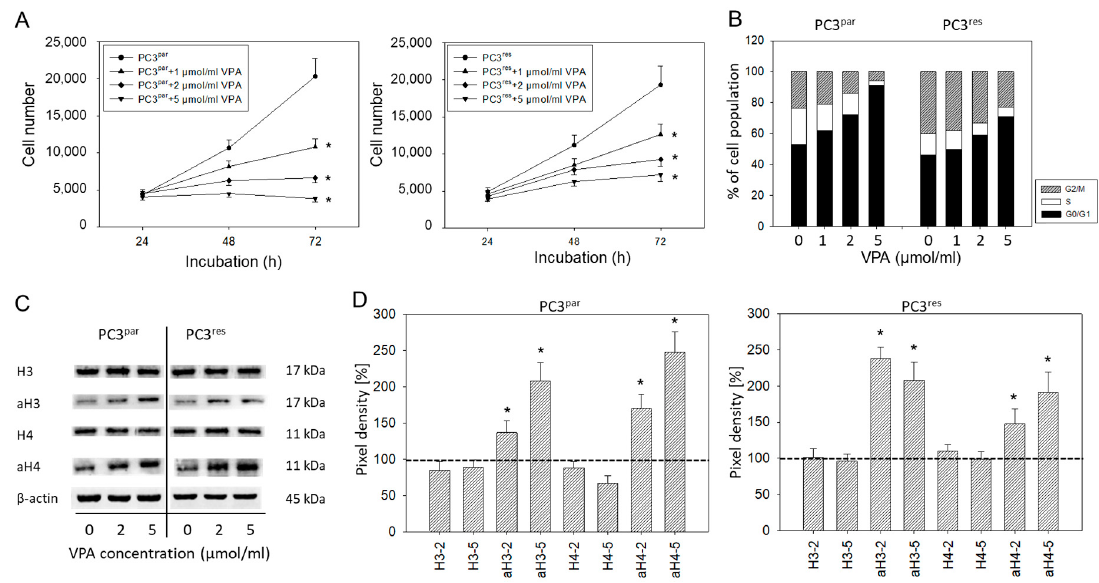
Figure 4. ( A ) Growth of PC3 par and PC3 res cells exposed to valproic acid (VPA). Controls remained untreated. Bars indicate standard deviation (SD). * indicates significant di ff erence to untreated control cells. One representative of n = 6. ( B ) Cell cycle analysis of sensitive and resistant PC3 cells treated with VPA. Controls (0) remained untreated. One representative experiment of three. ( C ) Influence of VPA on histone expression level. β -actin served as the internal control. ( D ) Histone pixel density analysis. 2 = 2 µ mol / mL VPA, 5 = 5 µ mol / mL VPA. * indicates significant di ff erence to untreated control